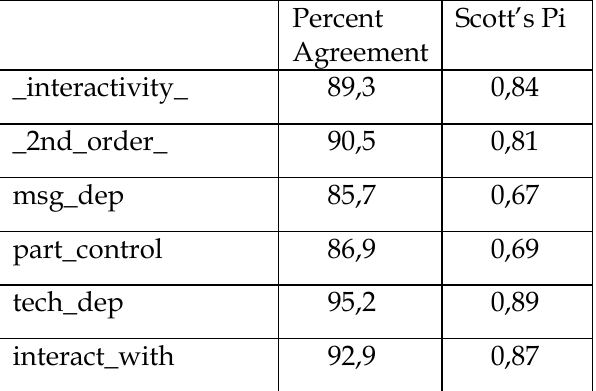
Table 2: Inter-Coder Reliability Test Scores Percent